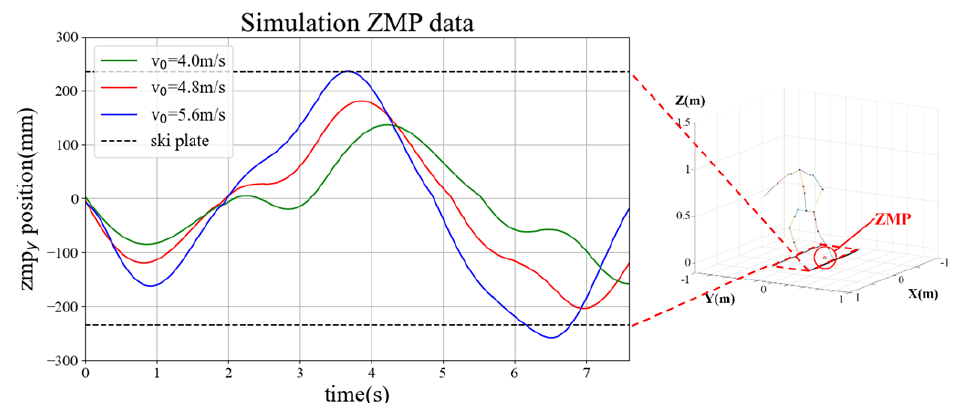
Figure 14. ZMP y variants according to